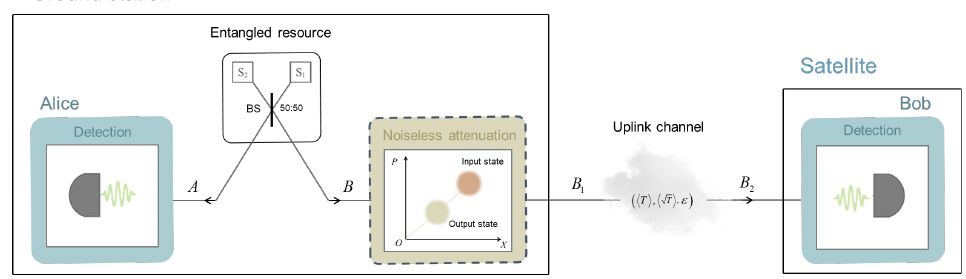
Figure 1. EB scheme of the NA-based CV-QKD in the uplink scenario. BS: beam splitter; T : channel transmittance; (cid:101) : channel excess noise; S 1 , S 2 : single-mode squeezed